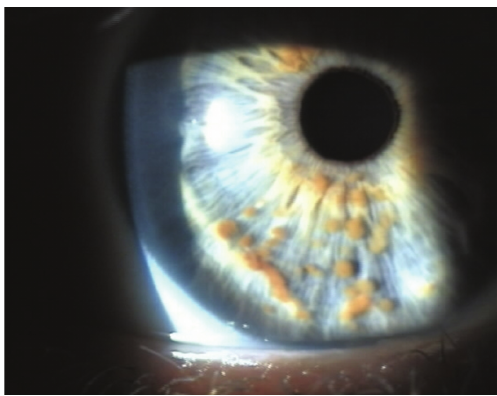
Figure 1: Multiple small, oval, yellow-brown papules (Lisch nodules) in the right